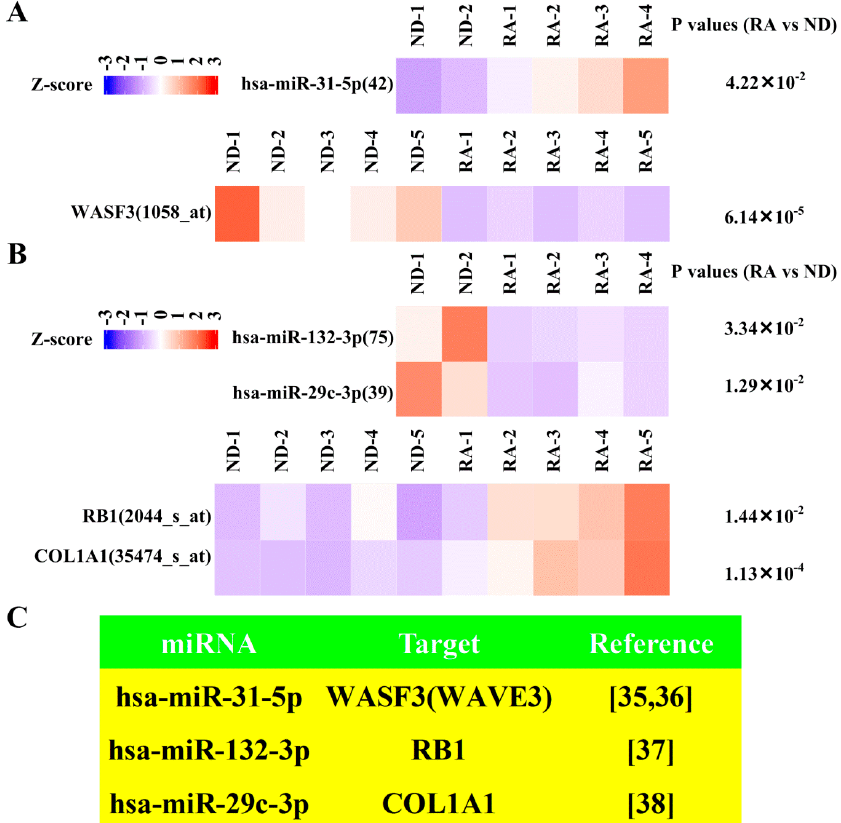
Figure 6. Expression of miRNA (hsa-miR-31-5p, hsa-miR-132-3p, hsa-miR-29c-3p) and corresponding targets (WASF3, RB1, COL1A1) in GEO dataset. ( A ) Heatmap showing the scaled expression of upregulated miRNA (hsa-miR-31-5p) and downregulated corresponding targets (WASF3) in rheumatoid arthritis (RA) synovial fibroblasts compared with normal donor (ND) synovial fibroblasts as well as P values in GSE1919 and GSE37276 with probe identification shown in parentheses. ( B ) Heatmap showing the scaled expression of downregulated miRNA (hsa-miR-132-3p, hsa-miR-29c-3p) and upregulated corresponding targets (RB1, COL1A1) in RA and ND synovial fibroblasts as well as P values in GSE1919 and GSE37276 with probe identification shown in parentheses. ( C ) Literature supporting interactions of miRNA and corresponding